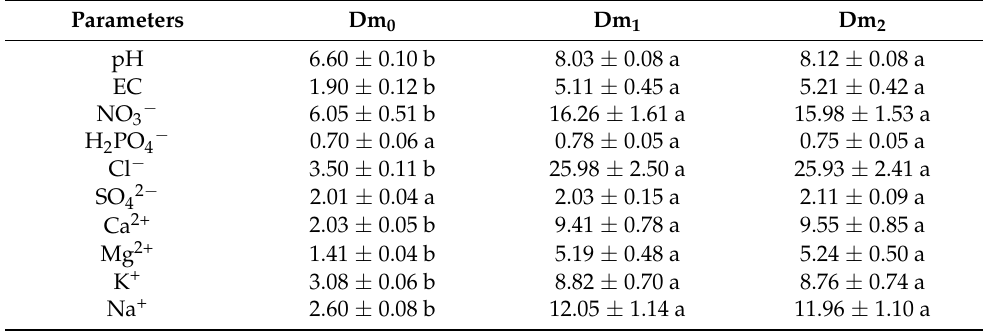
Table 1. The chemical parameters and nutrient concentrations of each treatment: Dm 0 —standard nu- trient solution, Dm 1 —raw leachate treatment, and Dm 2 —raw leachate blended with H 2 O 2 treatment. The electrical conductivity (EC) was expressed in dS m − 1 and nutrient concentration was expressed in mmoL L − 1 . The results are expressed as means ± standard deviation ( n = 4). In each row, different letters indicate significant differences ( p < 0.05).